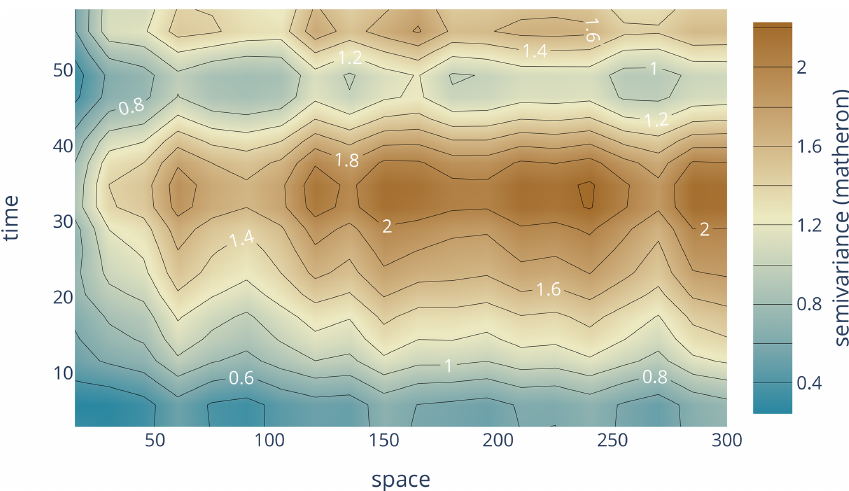
Figure 7. Contour plot of an experimental space-time variogram, without theoretical model. The shown variogram is from exactly the same instance as used for Fig. 6, without any modifications. The contours are calculated for the semi-variances ( z axis) and thus contain the same information as the scatterplot in Fig. 6. The color is indicating the magnitude of the semi-variance according to the color